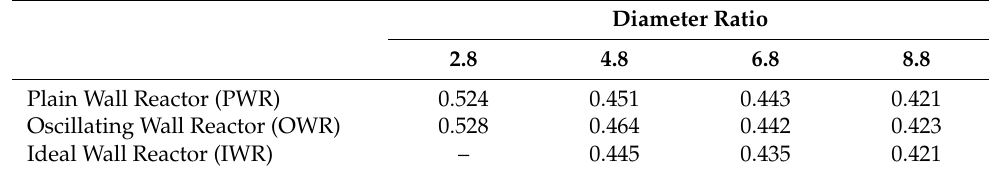
Table 5. Bed void fraction.